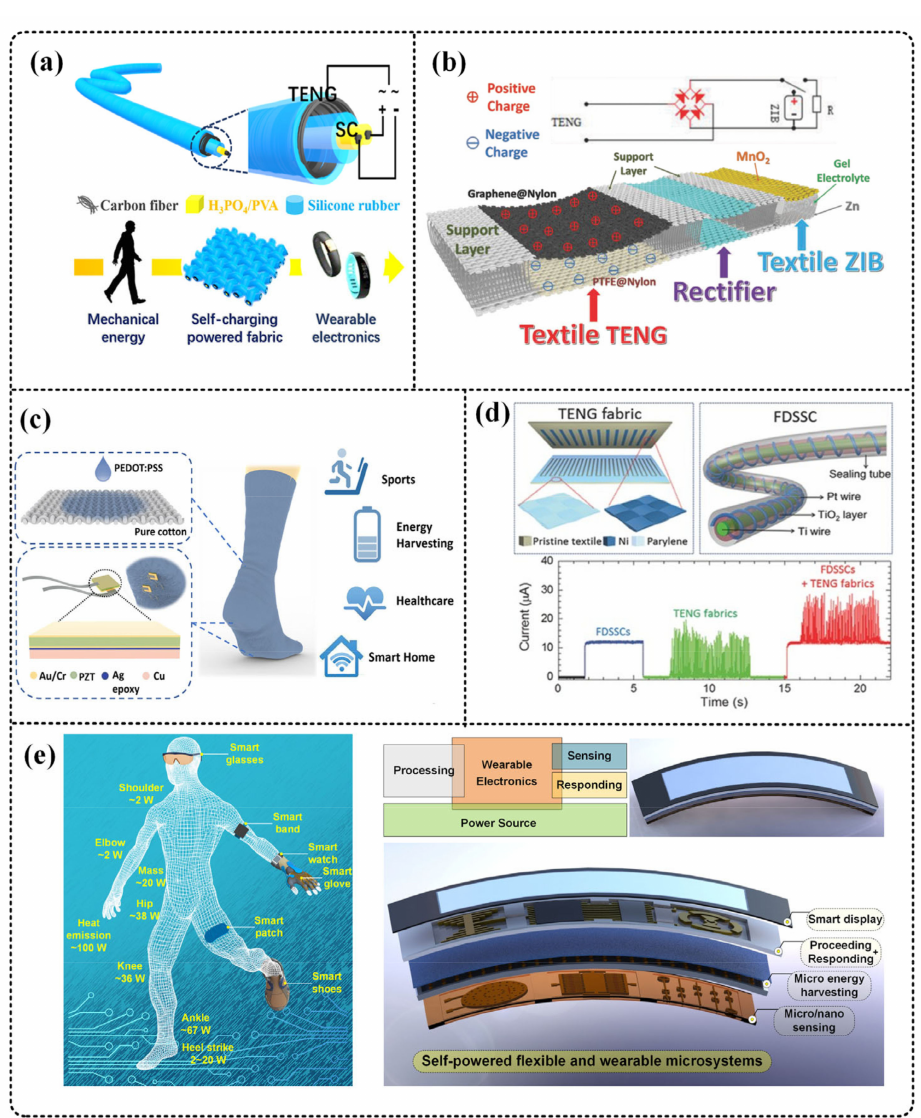
Figure 7. T-TENG serves as the basis for integrated microsystems. ( a ) Yang et al. used a coaxial structure to integrate TENG and SC into one fiber. Reproduced with permission from American Chemical Society (2016) [41]. ( b ) Wang et al. used 3D structure to integrate TENG, rectifier bridge, and Zn ion battery in a fabric. Reproduced with permission from Wiley (2018) [102]. ( c ) Zhu et al. mixed and integrated PEDOT:PSS-coated fabric TENG and lead zirconate titanate (PZT) piezoelectric chips. It can realize multi-sensing and energy harvesting. Reproduced with permission from American Chemical Society (2019) [42]. ( d ) Pu et al. integrated the fabric TENG with a grating structure and the fibrous dye-sensitized solar cell (FDSSC) into a cloth. Reproduced with permission from Wiley (2016) [104]. ( e ) All-in-one self-powered flexible microsystems proposed by Zhang et al. Reproduced with permission from Elsevier (2018)